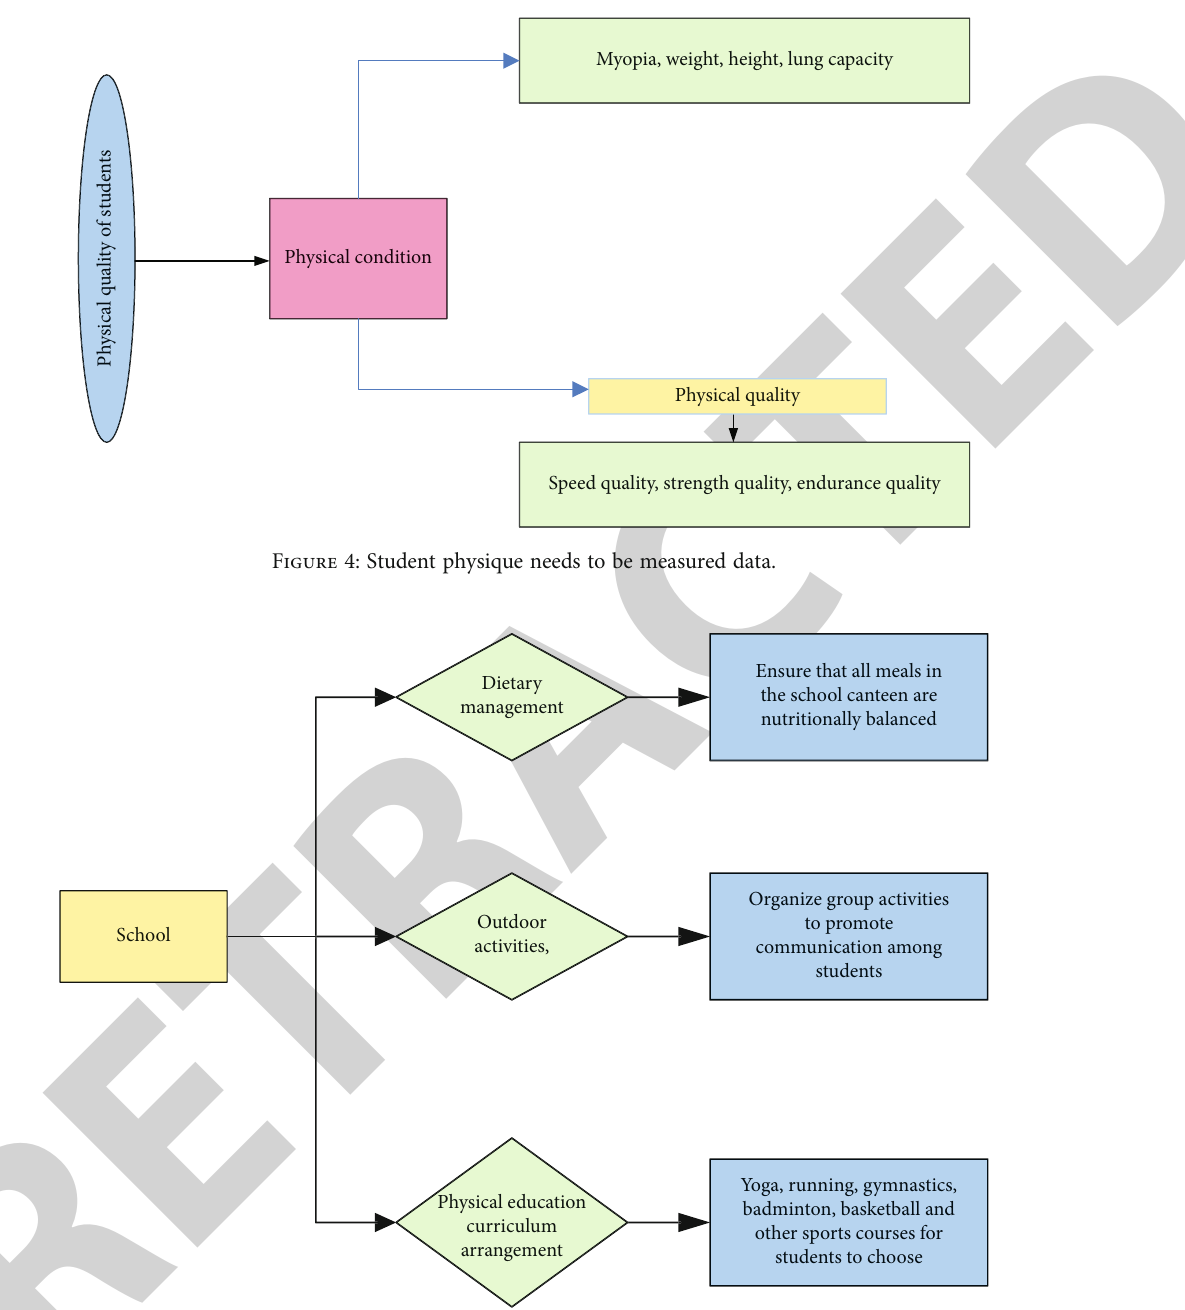
Figure 5: Scienti fi